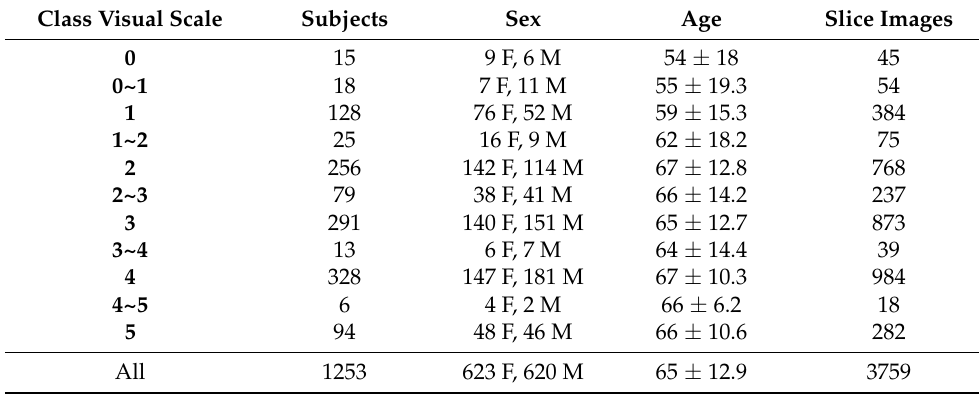
Table 1. Demographic information of the